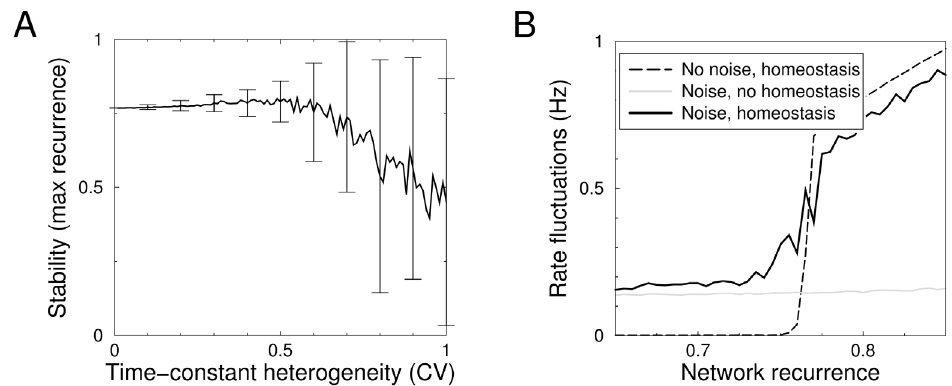
Fig 3. Effects of heterogeneity and noise on homeostatic stability of a network. A) The stability as a function of heterogeneity in the neurons ’ homeostatic time-constants. The time-constants τ 1 , τ 2 , τ 3 for each neuron were drawn from gamma-distributions with means 10, 50 and 100ms, respectively, and a CV given by the x-axis. The curve represents the mean maximal recurrence allowed to ensure a stable system. It decreases with heterogeneity. Error bars represent the standard deviation over 1000 trials. Simulation of 10 neurons, connected with a random, fixed weight matrix. B) Noise does not ameliorate instability. The fluctuations in the population firing rate, due to both noise and oscillations, are plotted as a function of the network recurrence. Without noise, fluctuations are only present when the recurrence exceeds the critical value (dashed curve). With noise, the fluctuations are already present in the stable regime and increase close to the transition point (solid curve). The homeostasis in the system amplifies noise compared to the non- homeostatic system (grey line). Homeostatic time-constants were 10, 50 and 100ms.